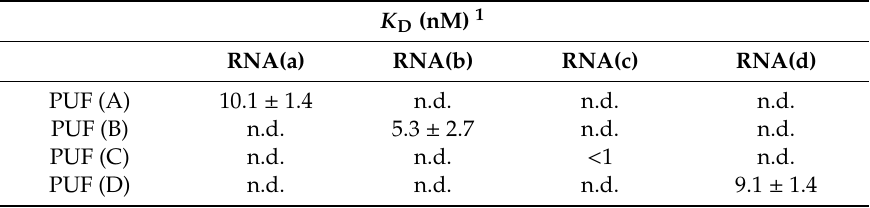
Figure 2. RNA binding of engineered PUF proteins to target RNAs. In the electrophoretic mobility shift assay (EMSA), RNA oligonucleotides, RNA (a)–(d), were incubated with corresponding PUF proteins, PUF (A)–(D), respectively, at the following concentrations (left to right): 0, 3.7, 11, 33, 100, 300 nM, and the mixtures were electrophoresed in native PAGE. “F” and “B” indicate protein-free RNA and protein-bound RNA, respectively. RNA (a) showed two protein-free bands (shown by *). Table 1. RNA binding of engineered PUF proteins to specific RNA